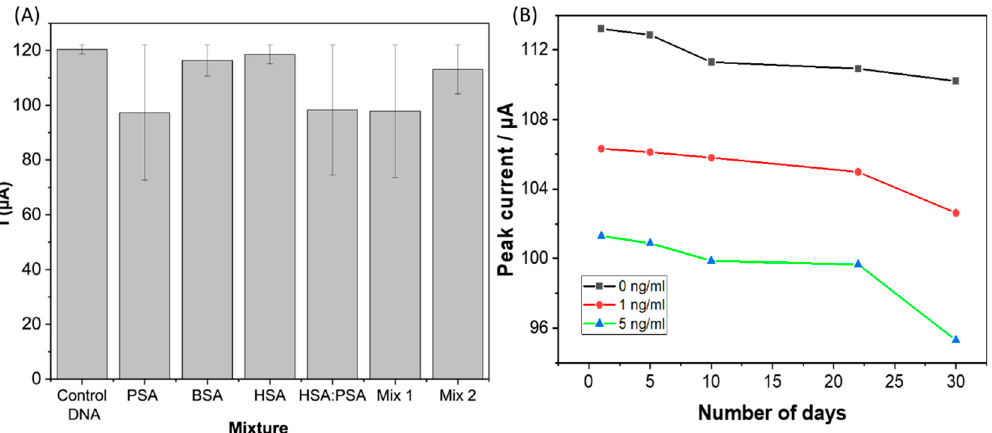
Figure 8. ( A ). Selectivity of the Aptasensor for PSA (10 ng/mL), detected against interferences, including HSA (10 ng/mL), PSA (10 ng/mL), BSA, (Mix1) = 10 ng/mL HSA + 5 ng/mL of PSA, (Mix2) = 10 ng/mL PSA + and 5 ng/mL HAS; ( B ) shows the shelf-life stability of sensor over a period of 30 days.